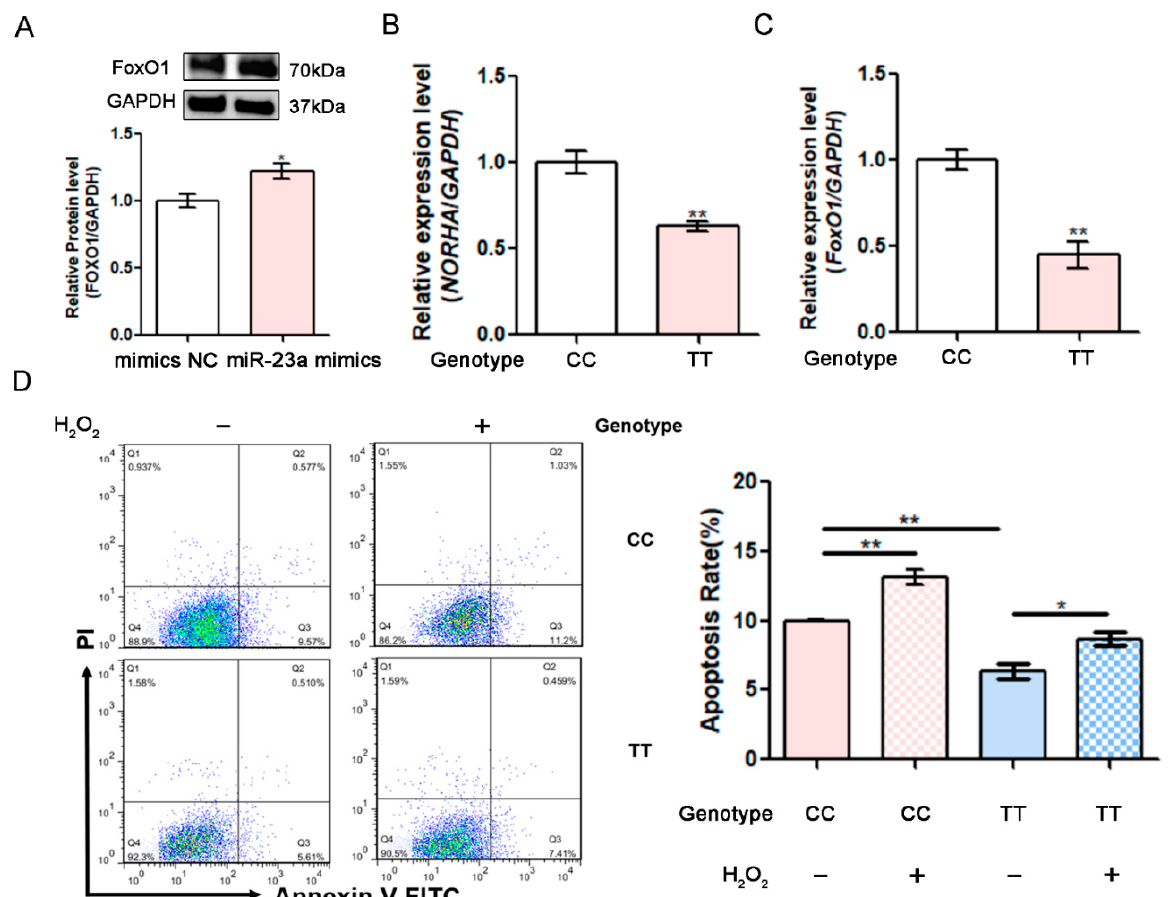
Figure 6. The miR-23a SNV g. − 398C > T affects the response of pGCs to oxidative stress. ( A ) After transfection with miR-23a mimics, FoxO1 protein levels were detected by western blotting in pGCs. ( B , C ) NORHA and FoxO1 levels were determined in pGCs from the ovaries of sows with genotype CC ( n = 3) and genotype TT ( n = 3). ( D ) The apoptosis rate was detected by FACS in pGCs at 2 h after being treated with 200 μ M H 2 O 2 . Data are expressed as the mean ± S.E.M., and significance was